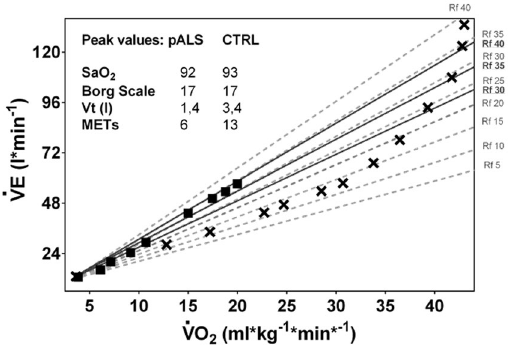
Figure 4. Relationships between  V O 2 and ventilation (  V E) values during exercise in representative participants from the pALS (black squares) and CTRL (crosses) groups. Individually, iso-respiratory frequency (Rf) lines are indicated (pALS, continuous lines; CTRL, broken lines).